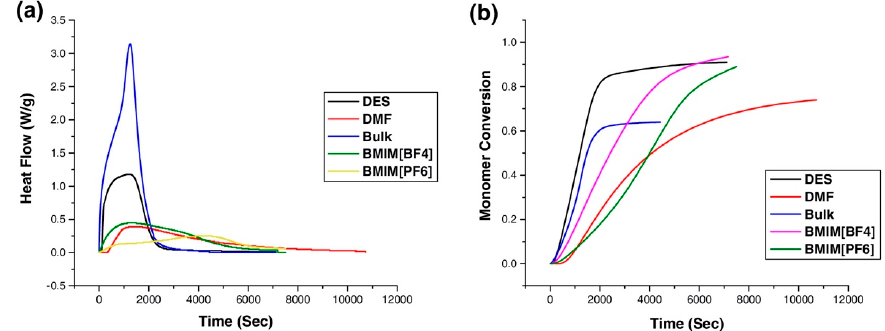
Figure 4. Calorimetric analysis of the reversible addition fragmentation chain transfer (RAFT) polymerization of 2-hydroxyethyl methacrylate (HEMA) in a variety of solvents; 2:1 urea:ChCl (black), DMF (red), bulk (blue) and ionic liquids (green, yellow, purple, respectively). Shown are heat flow vs. time ( a ) and conversion vs. time ( b ) for polymerization at 70 °C. Reproduced with permission from [77], Copyright 2019, John Wiley and Sons.